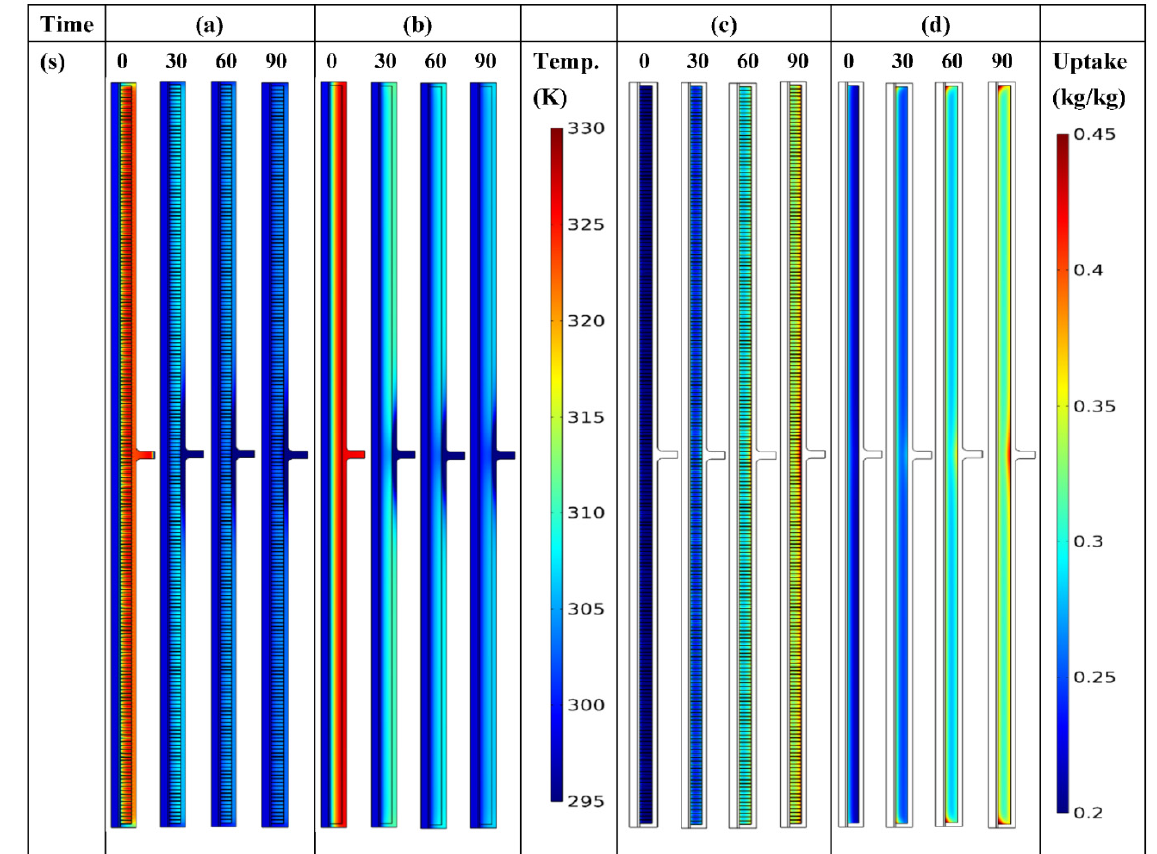
Figure 4. Numerical simulations for the spatial variations during the first 90 s of the adsorption: ( a , c ) the temperature and uptake for the finned tube bed, ( b , d ) the temperature and uptake for the aluminum foam bed.